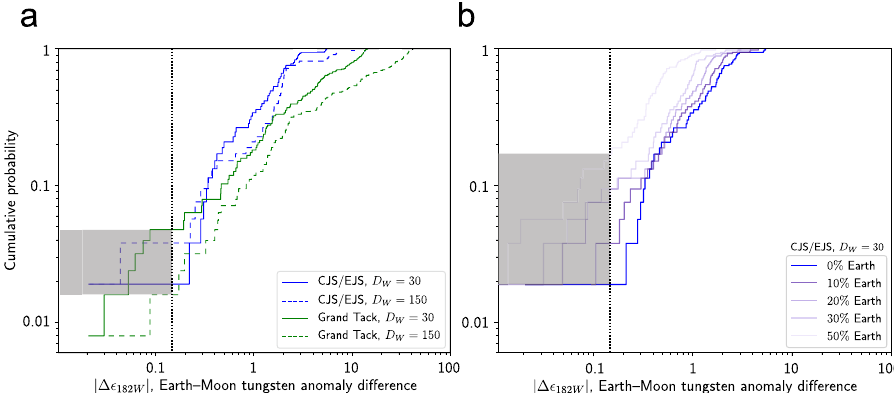
Fig. 3 The probability of an Earth-like lunar ε 182W . The cumulative probability of a range of Earth – Moon ε 182W differences is shown, given an Earth-like terrestrial ε 182W of 2.2 ± 0.15 (see ref. 5 ). Vertical dotted lines indicate the maximum Earth – Moon ε 182W difference allowed based on calculations of the Earth ’ s pre-late veneer composition, ±0.15 ε units (see ref. 5 ), and the gray shaded rectangles indicate the corresponding maximum probability of forming an Earth – Moon pair with an ε 182W difference no larger than this. Results for various fractions of equilibrating metal k (in the range 0.1 – 1) are combined. a Results for four combinations of accretion scenarios and lunar W metal – silicate partition coef fi cient D W , with the Moon made entirely of Theia materials (no terrestrial component). Blue lines: Circular Jupiter and Saturn (CJS) and Eccentric Jupiter and Saturn (EJS) simulations, combined. Green lines: Grand Tack simulations. Solid lines: D W = 30. Dashed lines: D W = 150. With the Moon made entirely from Theia materials, <1.6 – 4.7% of Earth – Moon pairs have ε ε units. b The effect of mixing Earth and Theia materials to form the Moon, with 0 – 50% of the mass of the Moon coming from 182W differences of <0.15 the Earth (indicated by color). Results are shown for CJS/EJS simulations and D W = 30. In this case, the probability of an Earth – Moon pair having an ε 182W difference of <0.15 ε units ranges from 1.9% (0% Earth materials) to 9.4% (20 – 30% Earth materials) to 17.0% (50% Earth materials). These probabilities are for W isotopes alone, and may be signi fi cantly lower when also considering stable